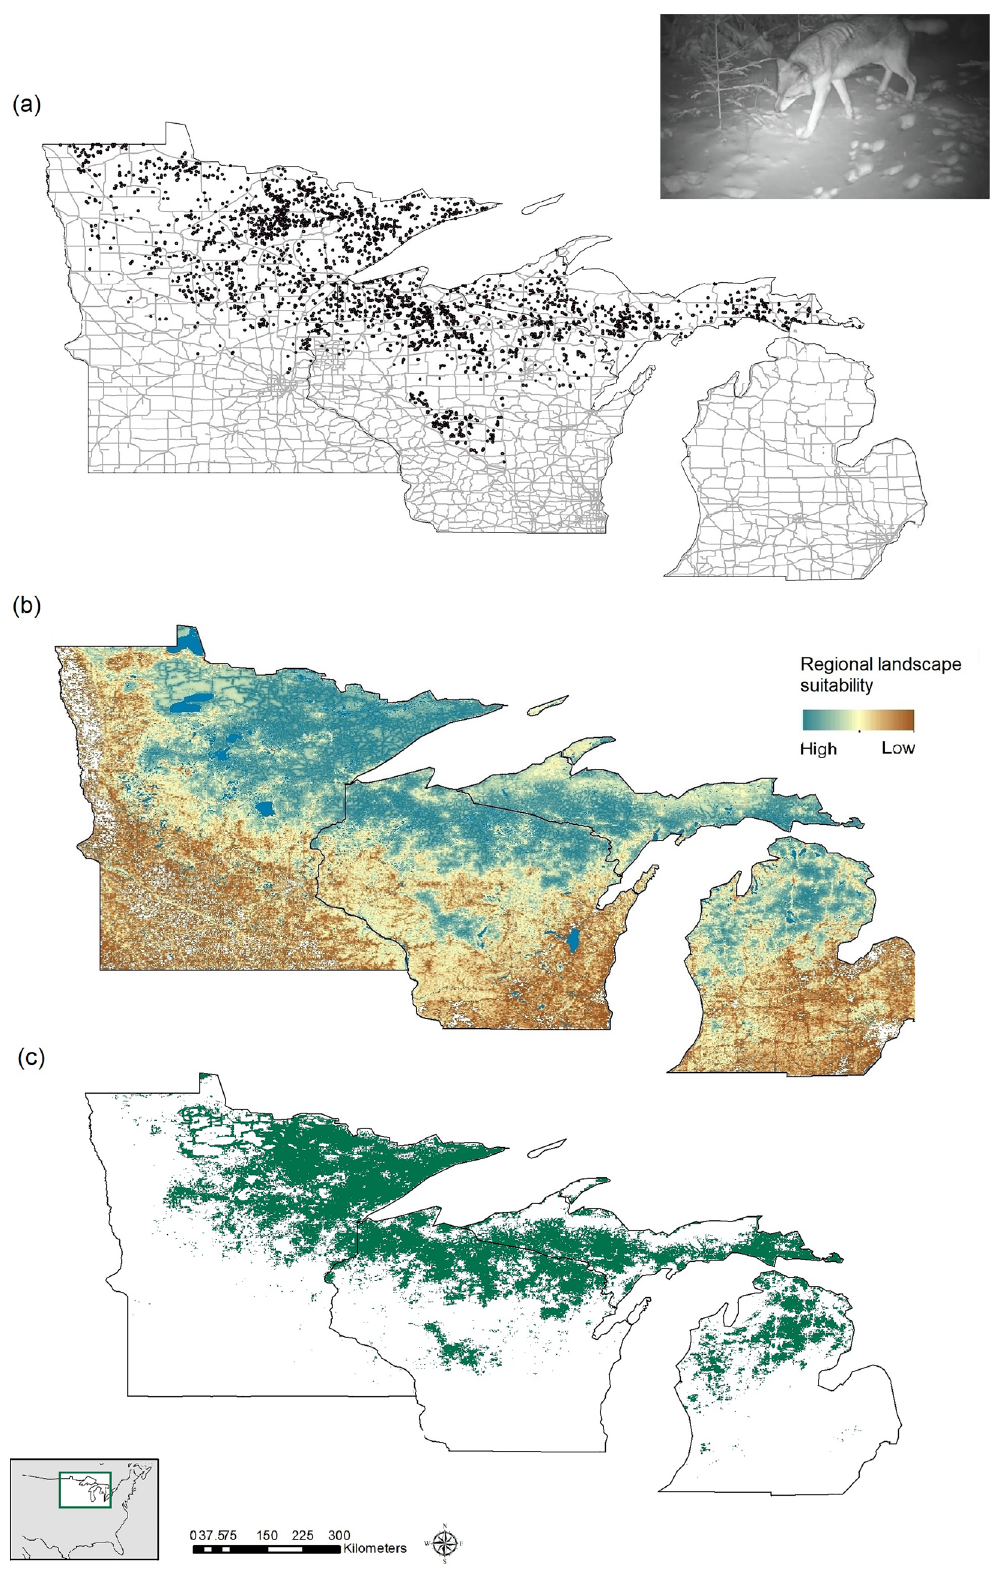
Figure 1. Wolf distribution in the western Great Lakes region, USA. ( a ) Wolf presence locations during 2017–2020 resampled to no more than one point per km 2 with major roads shown as grey lines. ( b ) Regional landscape suitability (see “Methods” and Fig. 2). ( c ) Binary map indicating areas most suitable for wolves (suitability threshold 47.5%, see “Methods”). Maps developed with ArcMap 10.8.1 (desktop.arcgis.com). Wolf photograph: J. Belant, Global Wildlife Conservation